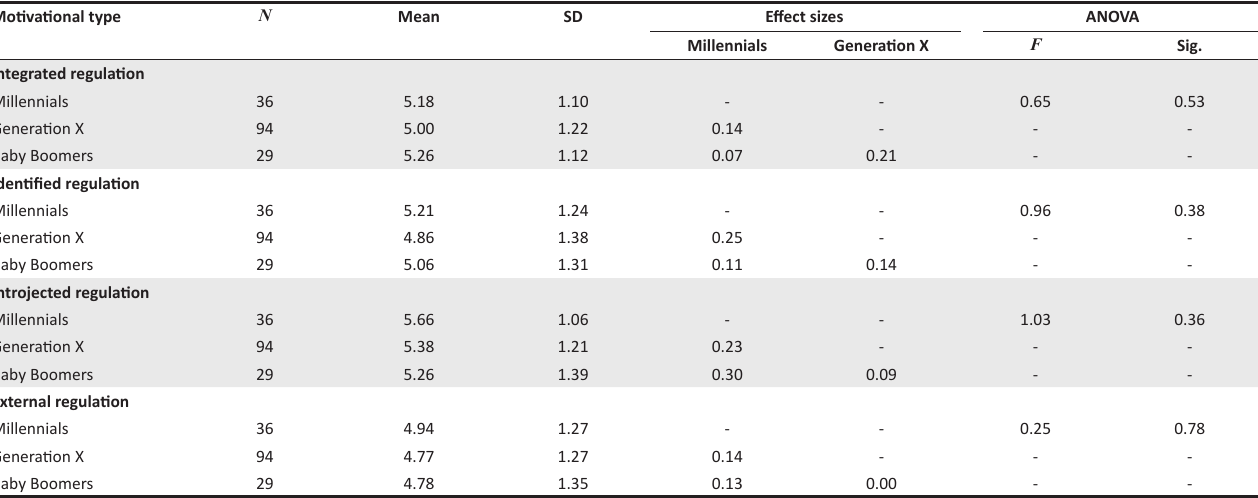
TABLE 3: Descriptive statistics, analyses of variances and effect size results for the sub-scales of extrinsic motivation. Motivational type